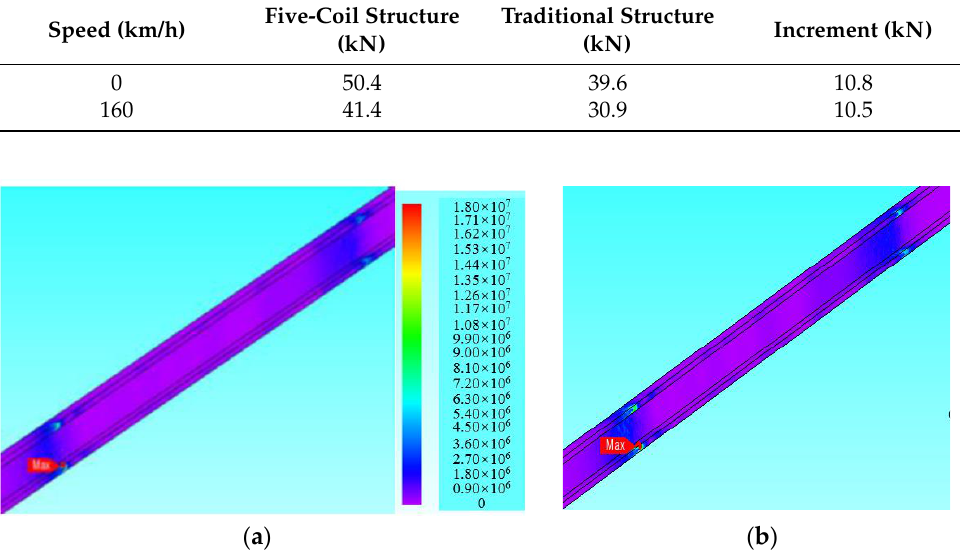
Figure 8. 3D FEM model of five-coil structure. Table 6. Levitation Force of Five-coil Electromagnet Structure.